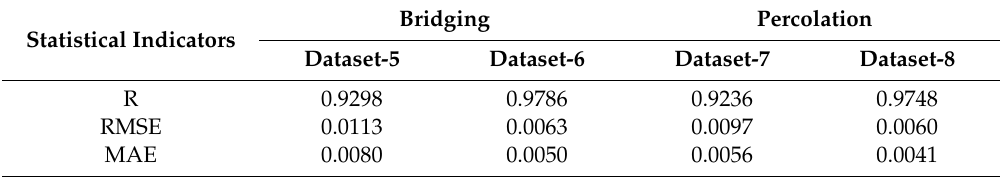
Table 6. Statistical performances of FNN model (for testing data) along the flume